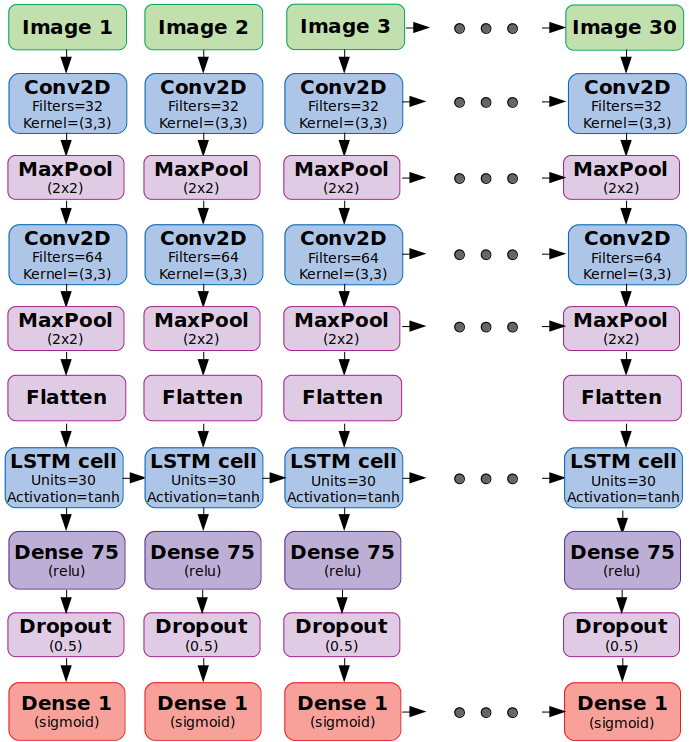
Figure 7. CNN-based model architecture. Green refers to the input layer, blue and purples to the hidden layers, and red to the output layer. Parallel processing has been done using the time-distributed wrapper from the Keras